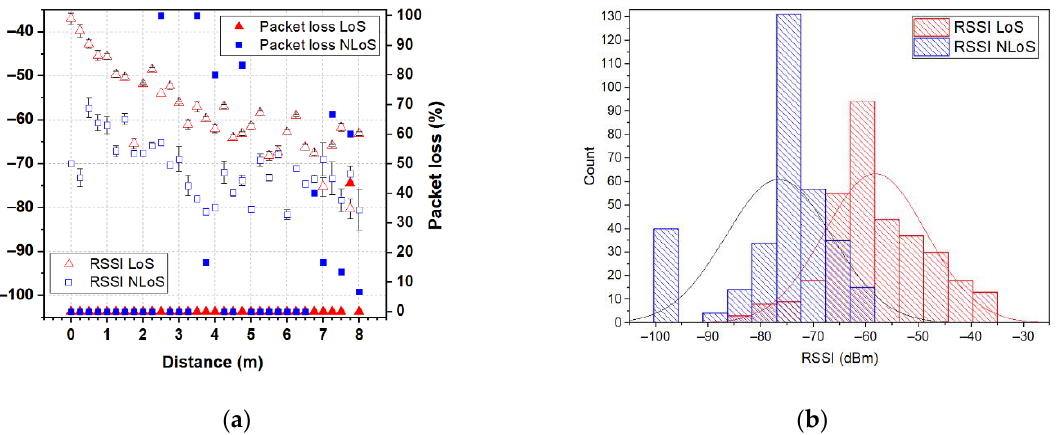
Figure 15. RSSI and packet loss for the backpack-integrated antenna prototype in the case of a backpack with a laptop: ( a ) distributions with respect to the distance between the antennas; ( b ) histograms. The RSSI and packet loss for all positions in the LoS scenario are displayed with red triangles. The RSSI and packet loss for all positions in the NLoS scenario are displayed with blue squares.